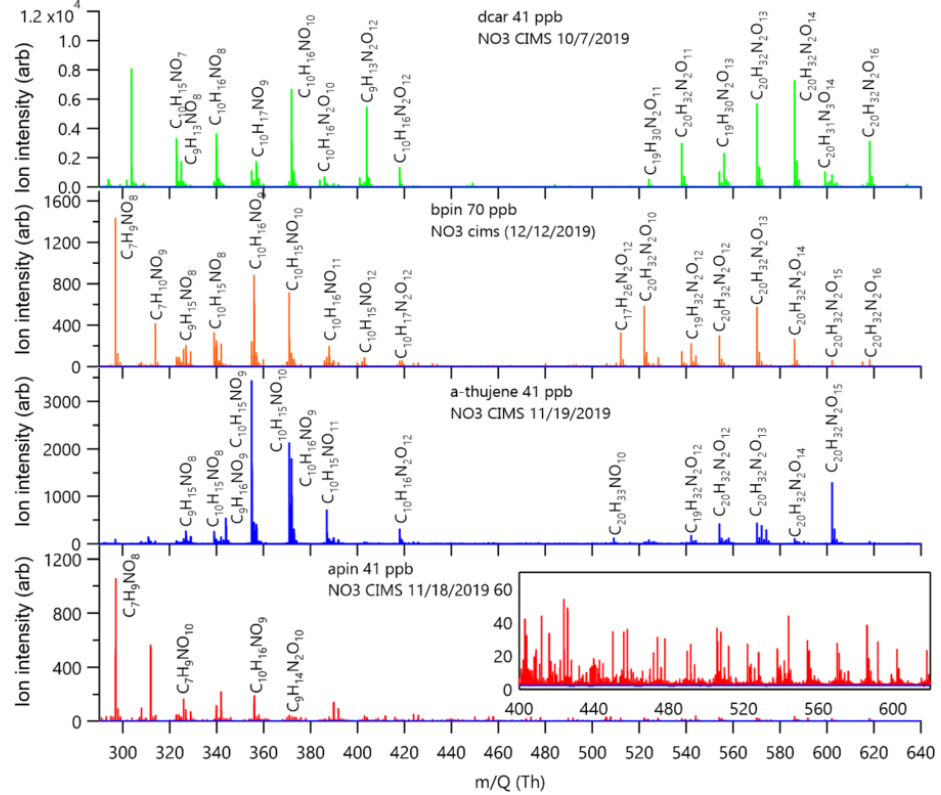
− reagent ion is not included in assigned formula. The left axes are 3